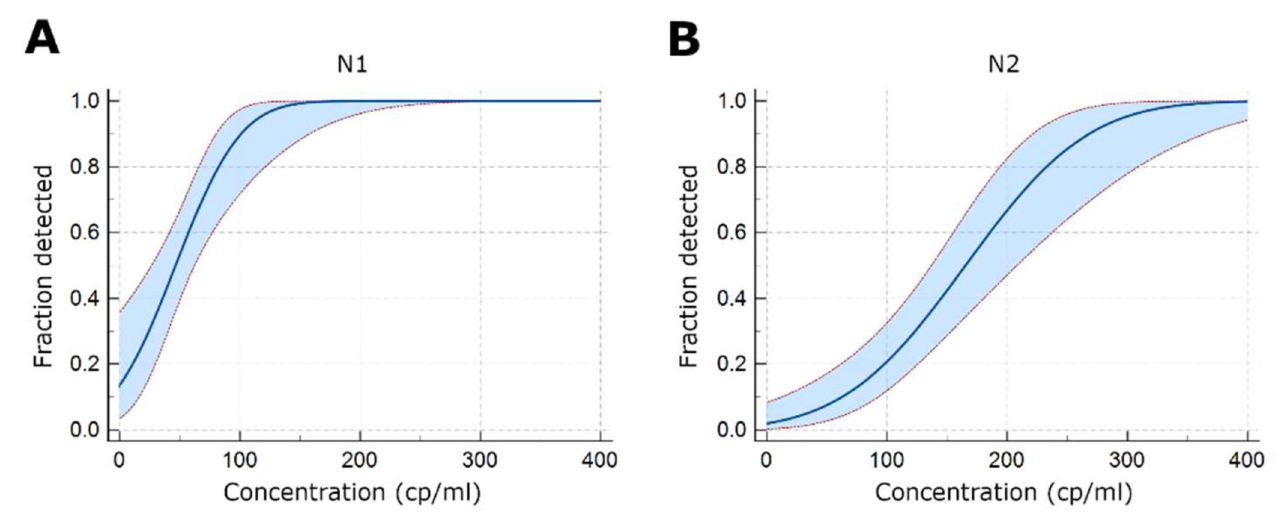
Figure 1. Analytical LoD of the test. ( A ) Region N1 ( B ) Region N2. Results from 20 replicates per dilution are shown. The 95% confidence interval is indicated in the light blue region.